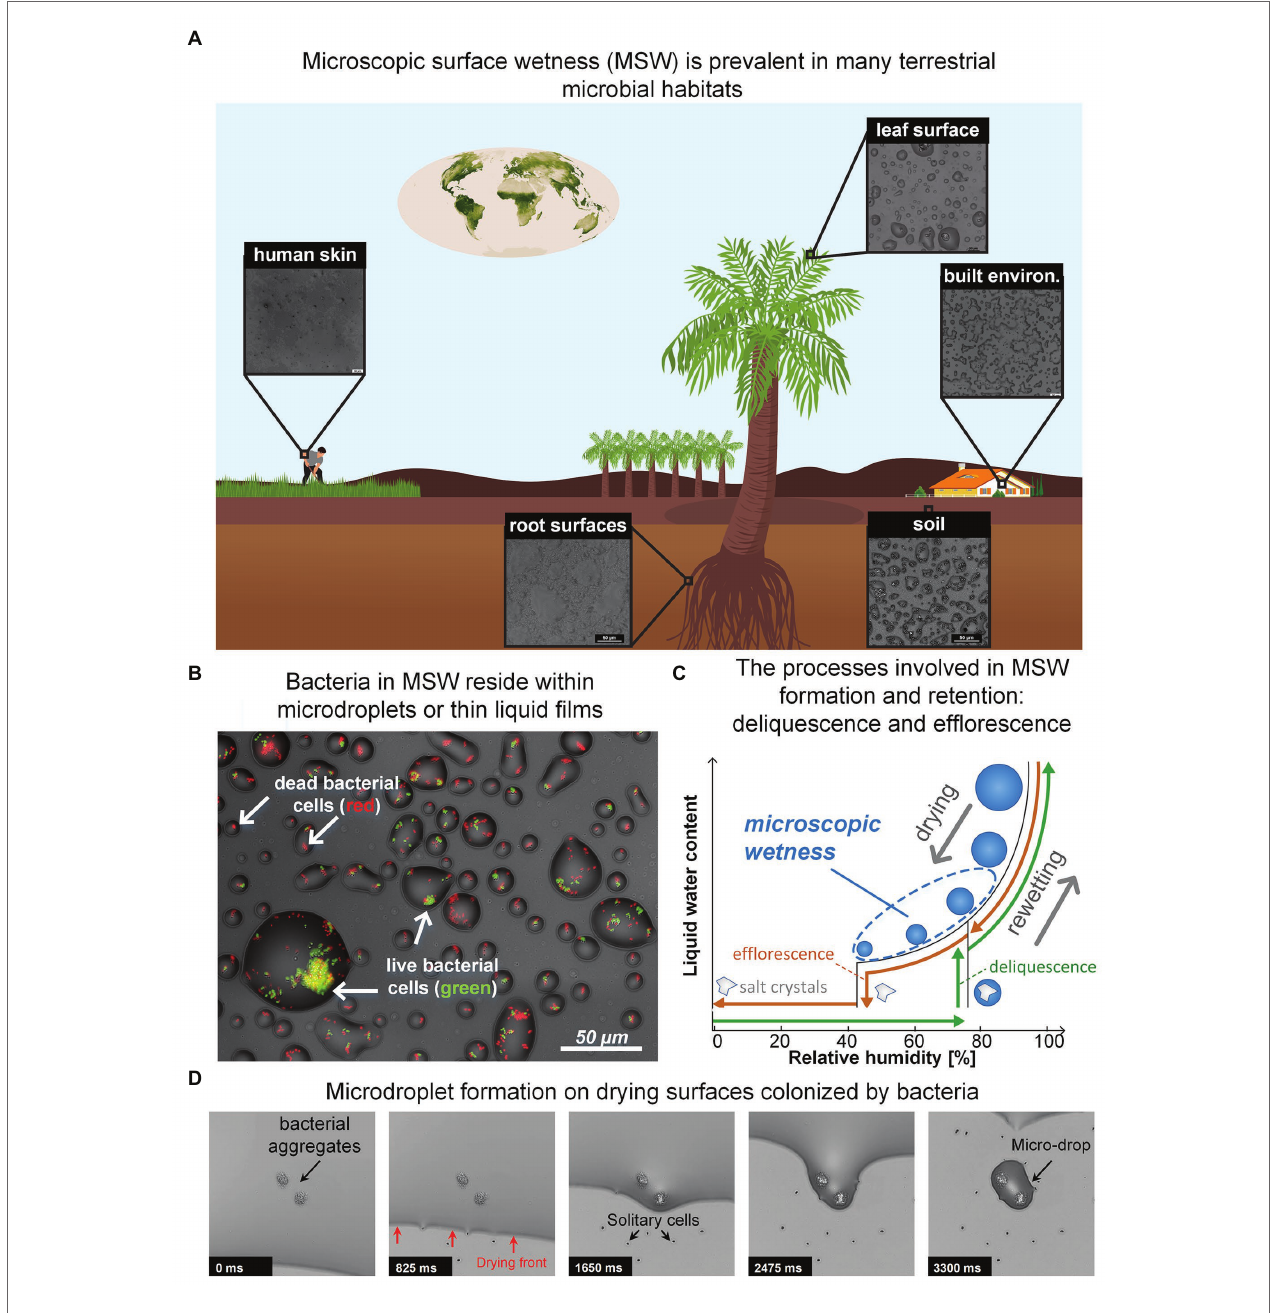
FIGURE 1 | (A) Microscopic surface wetness (MSW) is predicted to exist in various terrestrial microbial habitats. Insets show MSW images that result from natural samples that were dried on glass surfaces at 60–70% RH. The chemical compounds necessary for MSW formation, e.g., deliquescent compounds, are abundant in most terrestrial microbial habitats. (B) Bacteria in MSW. Bacteria in larger microdroplets typically exhibit higher survival. (C) A hysteresis diagram describing the underlying processes driving the formation and retention of MSW. Drying of a solution that contains deliquescent compounds leads to the formation of MSW when the RH is above the compounds’ efflorescence point (brown path). In the opposite direction – i.e., rewetting – solid crystalline deliquescent compounds turn into MSW when the RH is above their point of deliquescence (green path). Typically, the efflorescence point is lower than the deliquescence point of a specific salt. (D) Time lapse showing how microdroplets are formed around bacteria aggregates and cells on a drying surface. (Panel A : Earth vegetation map is from NASA website; Panels B and D : images adapted from Grinberg et al.,